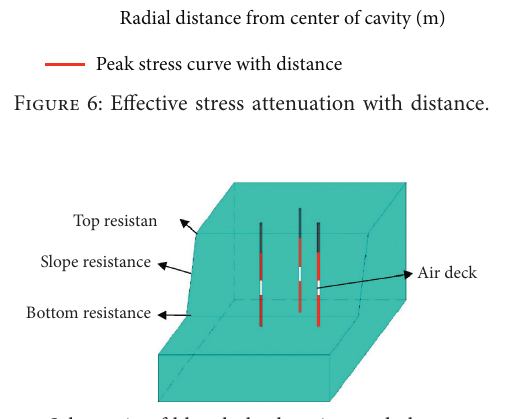
Figure 7: Schematic of blast holes location and charge